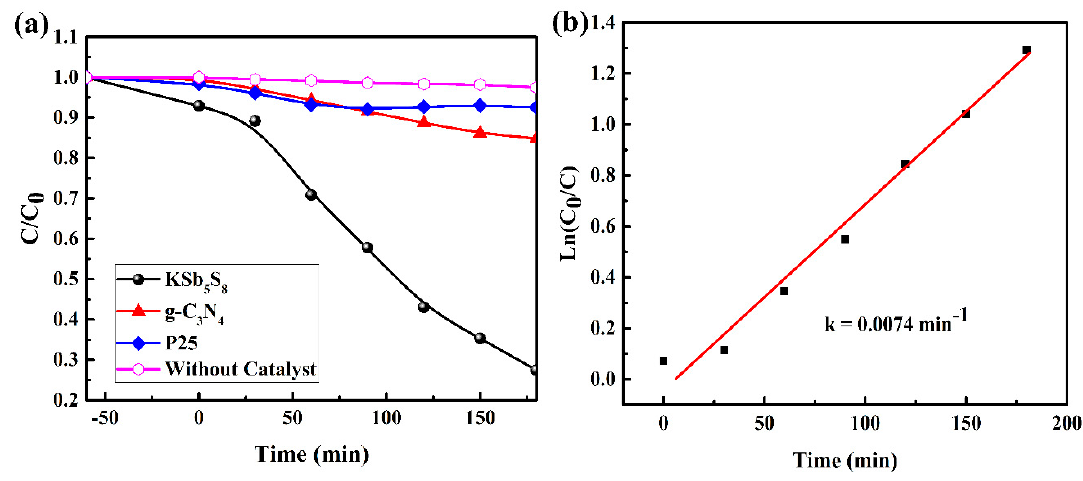
Figure 5. ( a ) Photocatalytic degradation curves of methyl orange (MO) over P25, g-C 3 N 4 , and KSb 5 S 8 under visible light irradiation. ( b ) Corresponding linear fitting curve of lnC 0 / C as a function of time for KSb 5 S 8 .